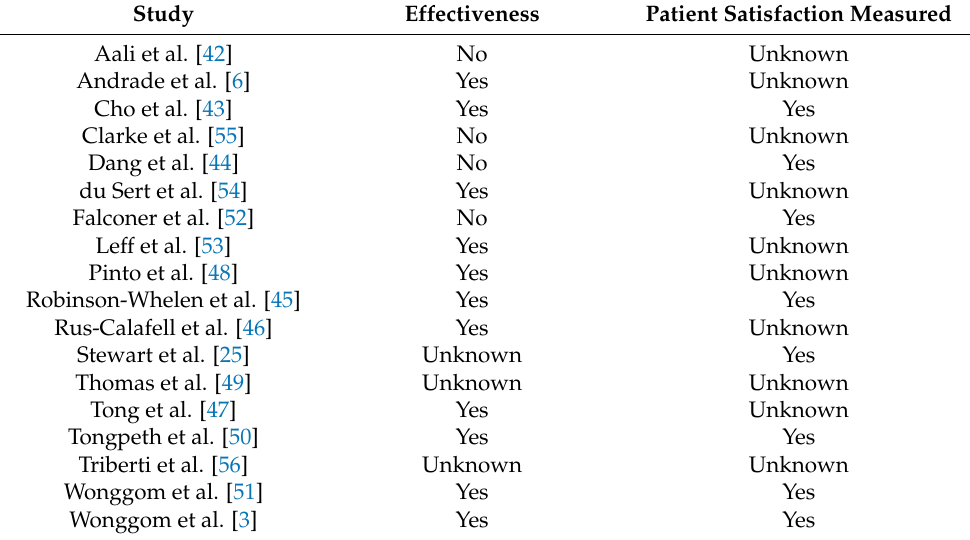
Table 4. Effectiveness and patient